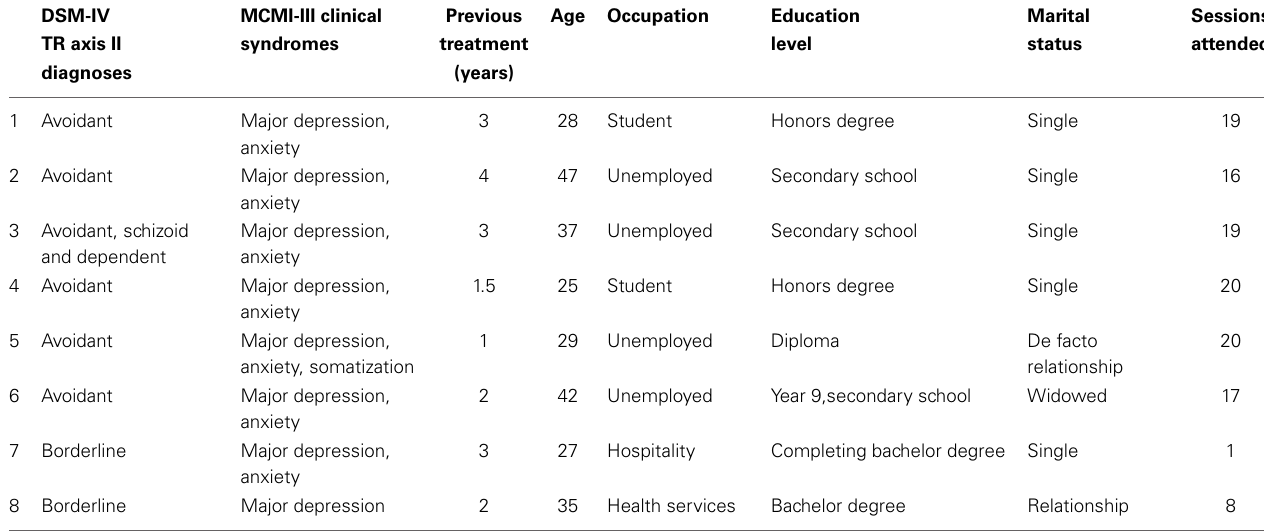
Table 1 | Sociodemographic